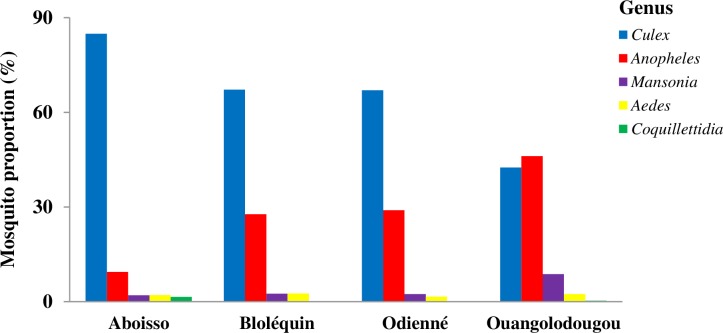
Abundance of mosquito genera collected in cross-border districts of Côte d’Ivoire.